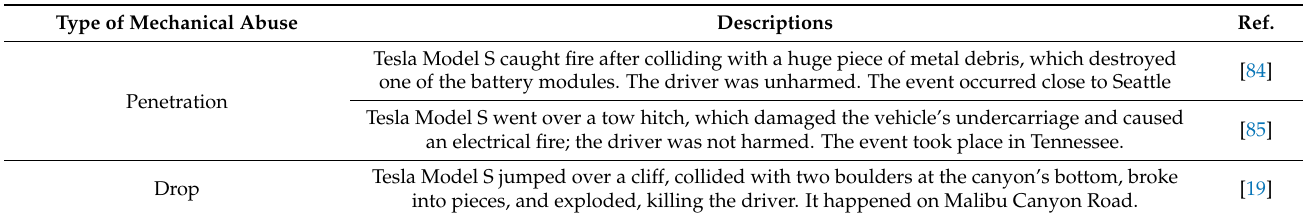
Table 3. Real-world EVs’ fire incidents in the form of mechanical